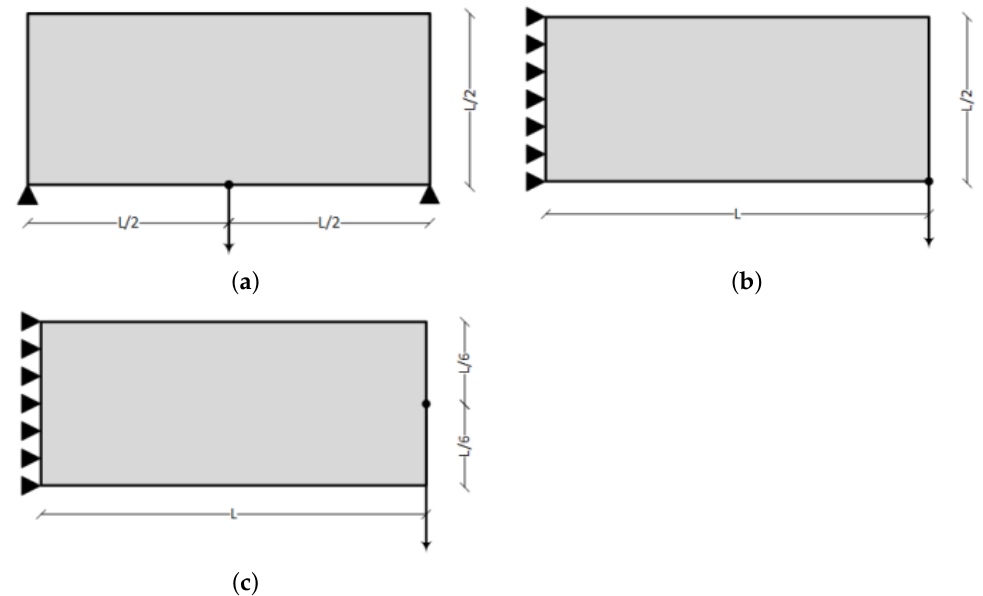
Figure 3. Test examples considered. ( a ) Bridge test example. ( b ) Cantilever beam 1 test example. ( c ) Cantilever beam 2 test